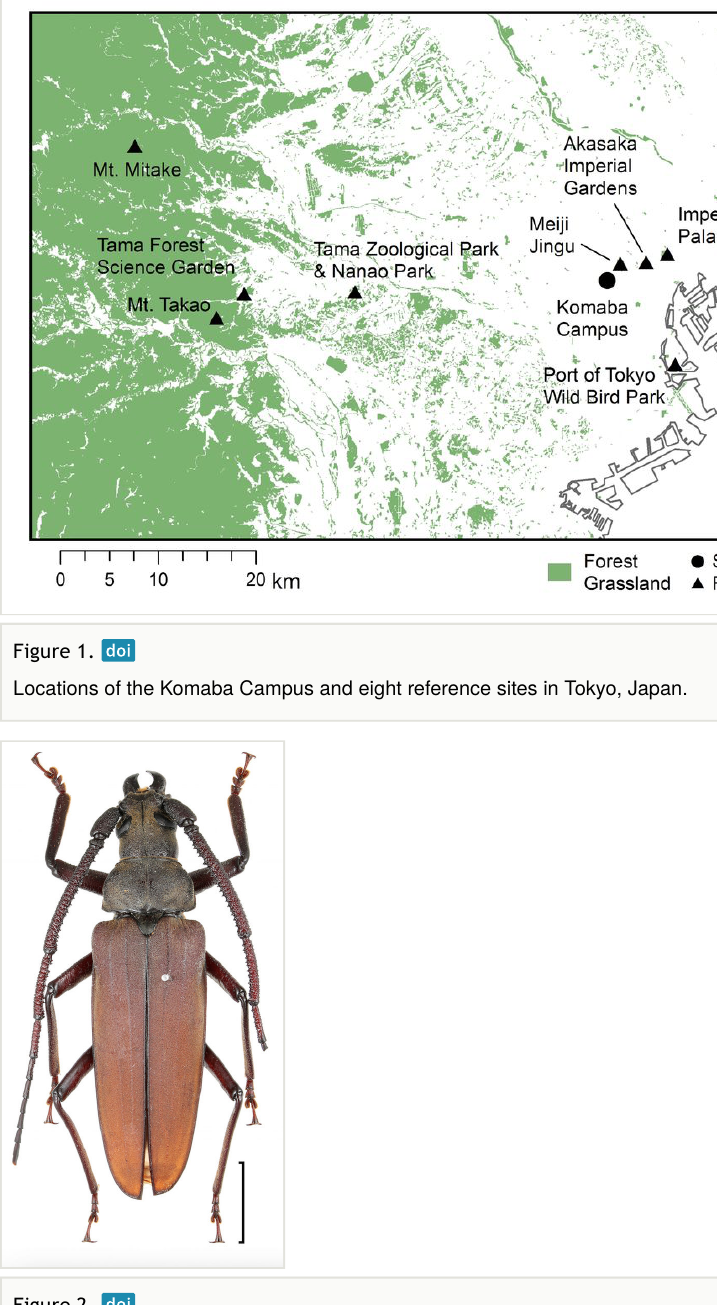
Figure 2. Aegosoma sinicum sinicum White, 1853. Scale bar 1